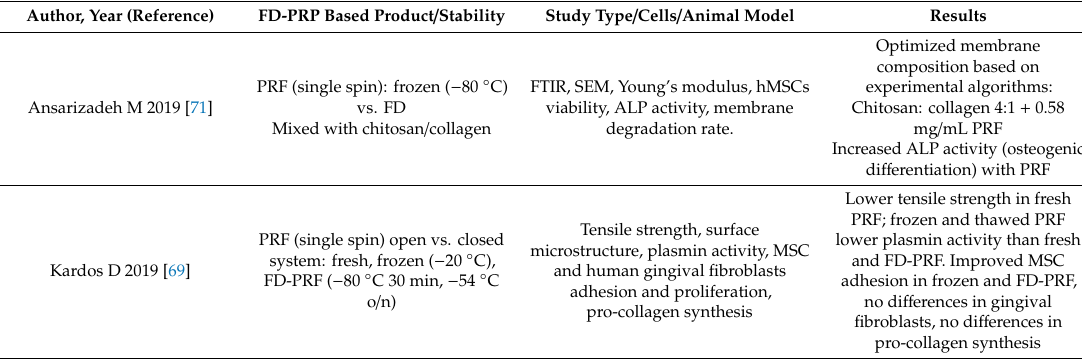
Table 3. Studies in dentistry